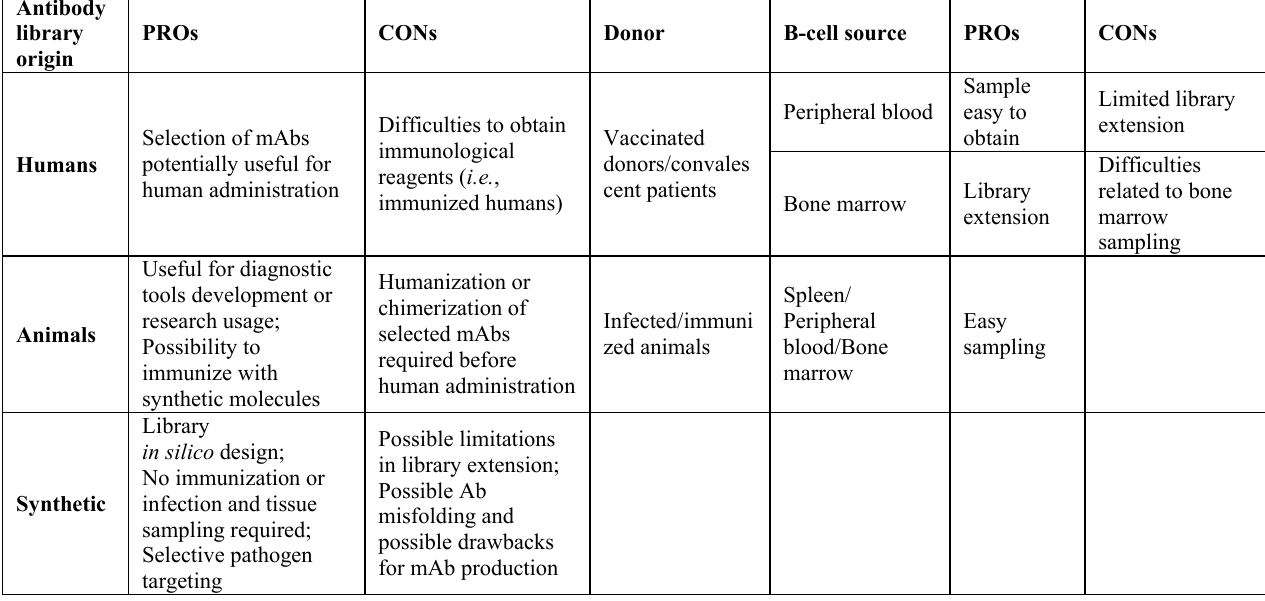
Table 1. Advantages and disadvantages of alternative sources of phage-displayed antibody